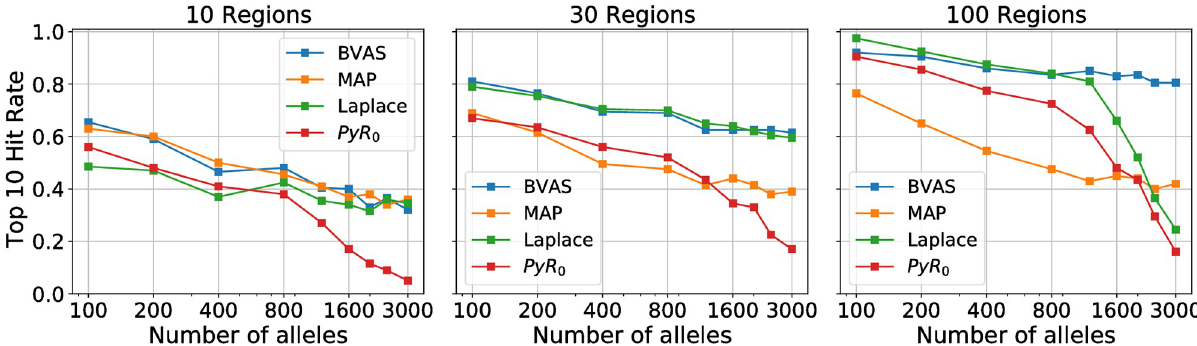
Fig 1. Hit rate comparison. We compare the hit rate for four different methods using simulated data, where the hit rate is defined as the fraction of the top 10 hits that are causal. Results are averaged across 20 independent simulations. See Sec. 3.2 for discussion.